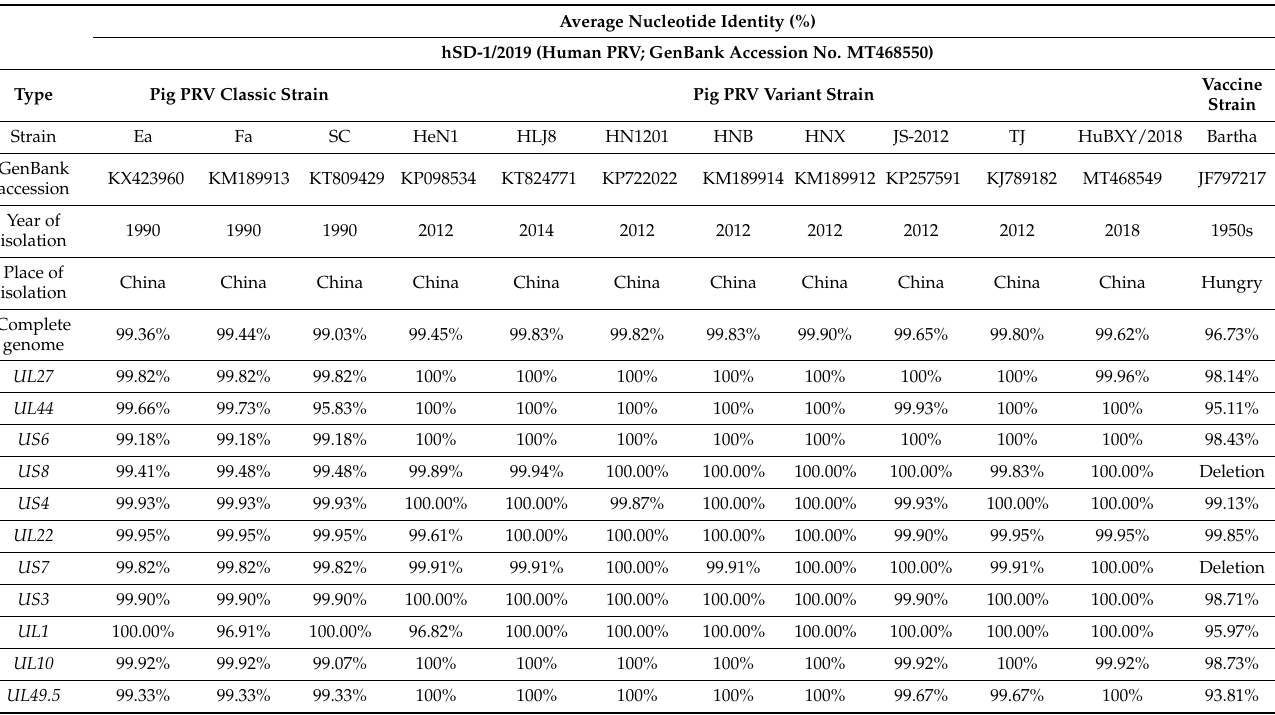
Table 1. Nucleotide sequence identities between hSD-1/2019 and pig PRV representative